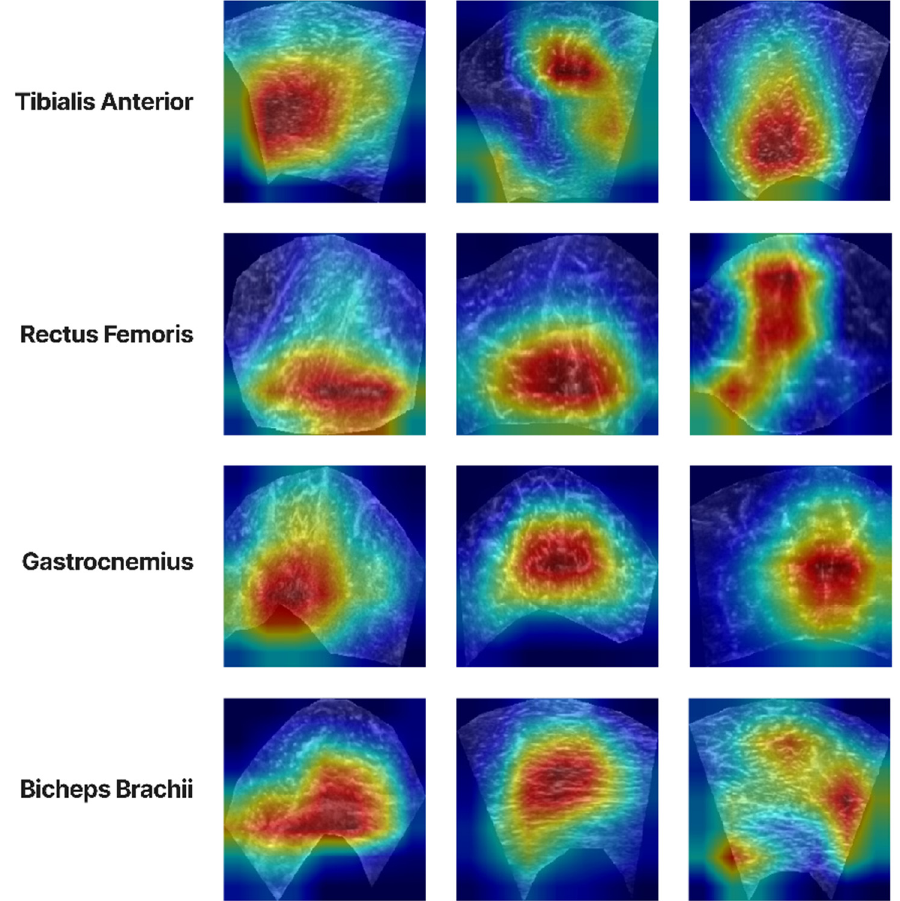
Figure 15. Grad-CAM analysis for the group classification of each muscle section.